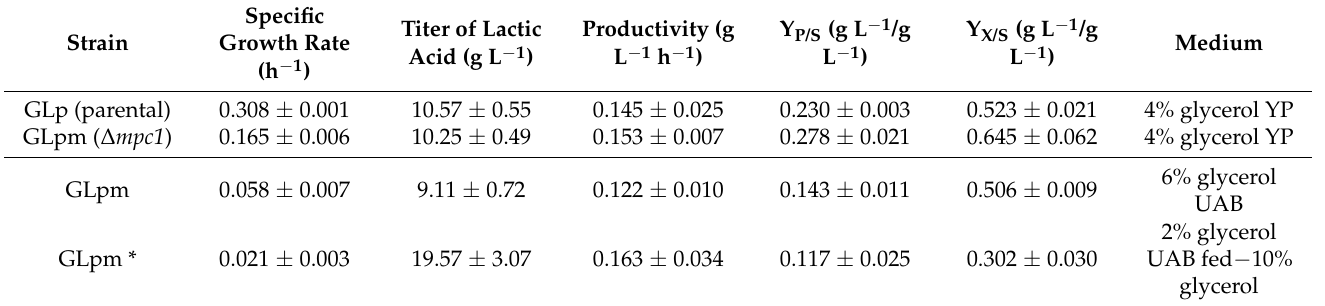
Table 3. Lactic acid production by the GLpm-engineered strain in the